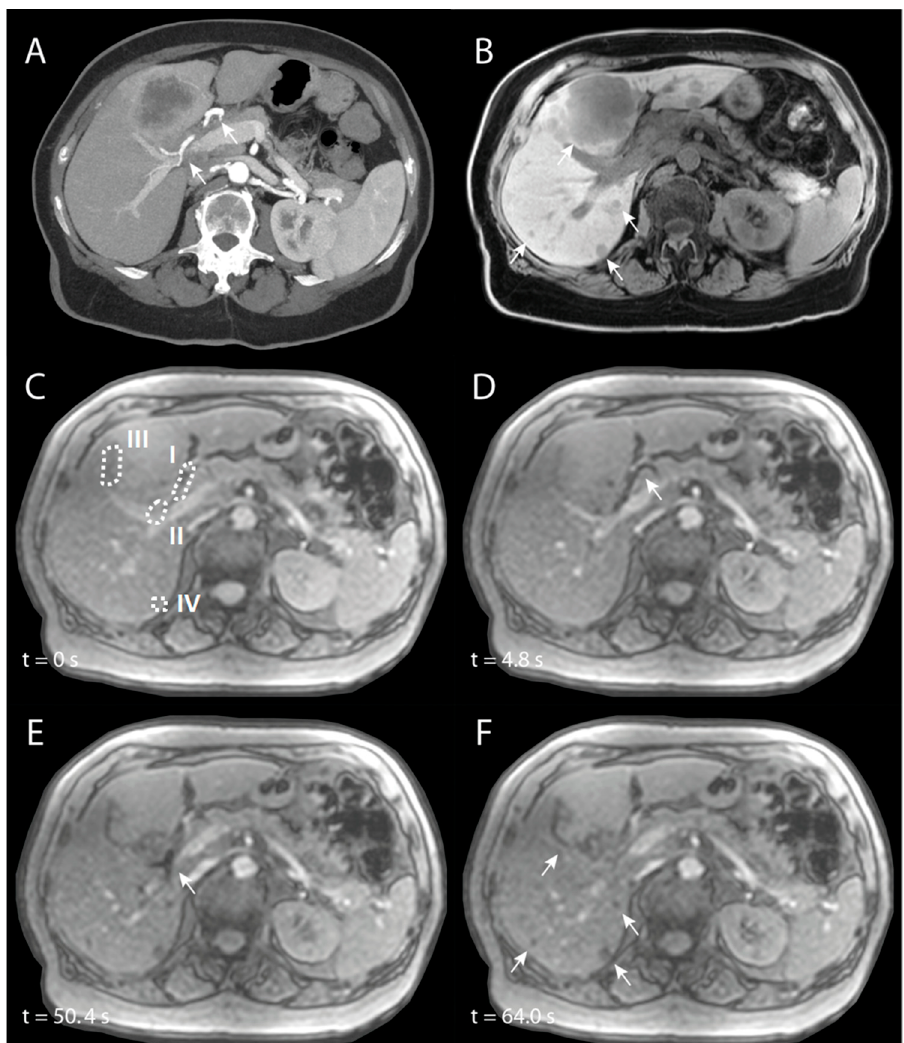
Figure 9. Imaging of a patient with intrahepatic cholangiocarcinoma, of whom the right hemiliver is treated with selective internal radiation therapy. ( A ) is a maximum-intensity projection of an arterial phase CT in which the right hepatic artery (RHA) is annotated with arrowheads. ( B ) is a corresponding non-enhanced T1-weighted MRI in which multiple tumours are visible (arrowheads). ( C ) to ( F ) are chronologic frames from the near real-time imaged holmium-166 microspheres injection: ( C ) is just before injection, with VOIs used for signal quantification annotated with dashed lines. In ( D ), there is loss of signal because of the microspheres in the proximal RHA (arrowhead) and in ( E ) in the more distal RHA (arrowhead). ( F ) is the end of near real-time administration, in which there is loss of signal mainly at the tumour sites (arrowheads) that was not visible prior to injection ( C ).